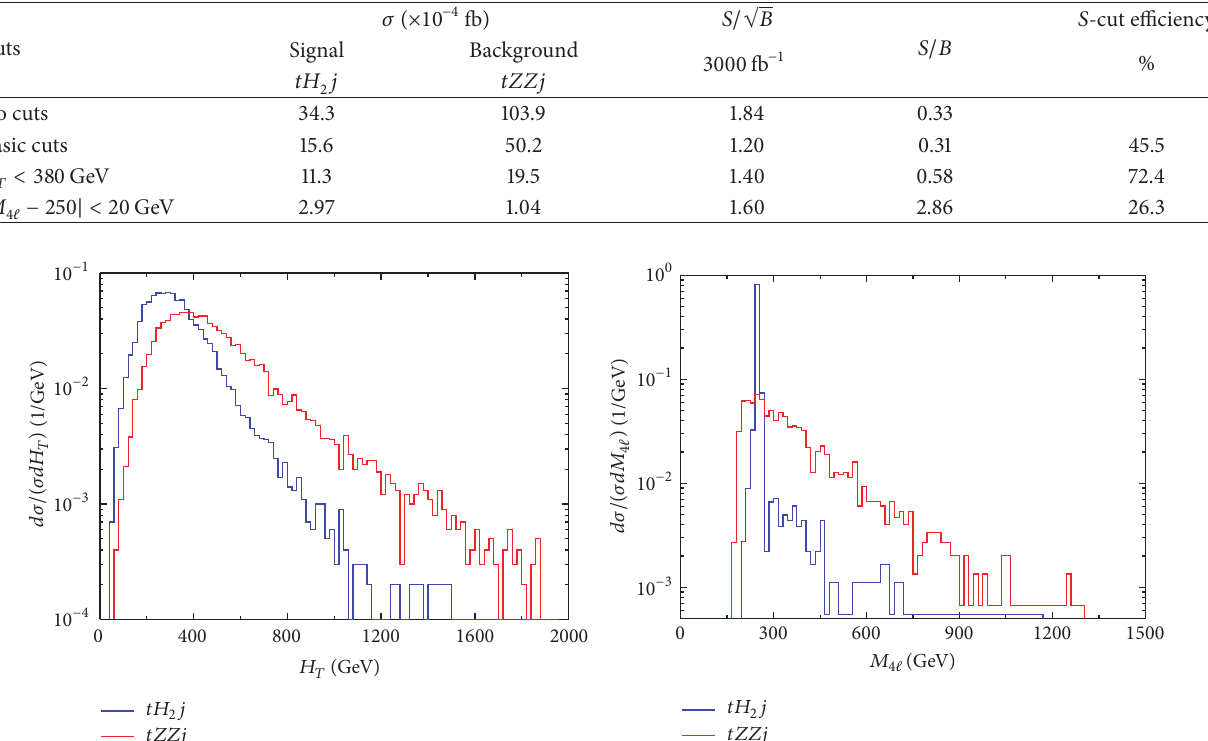
Table 1: Cutflow of the cross sections for the signal and backgrounds at 14 TeV LHC on the benchmark point ( 𝑚 𝐻 All the conjugate processes of the signal and background have been included.